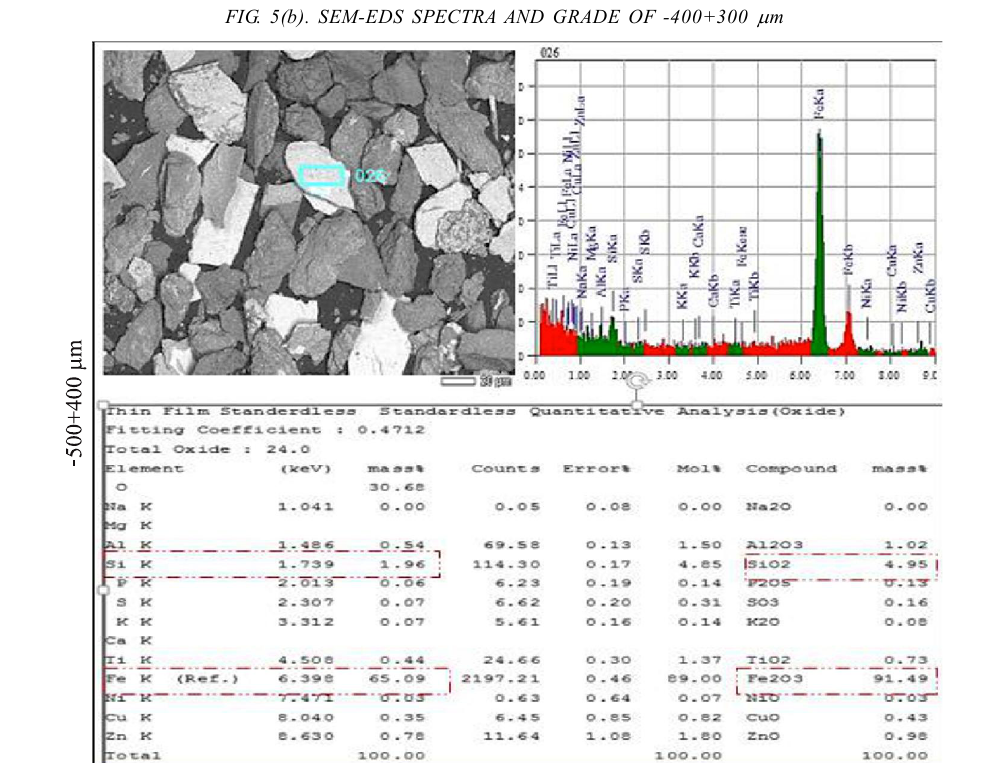
FIG. 5(c). SEM-EDS SPECTRA AND GRADE OF -300+150 